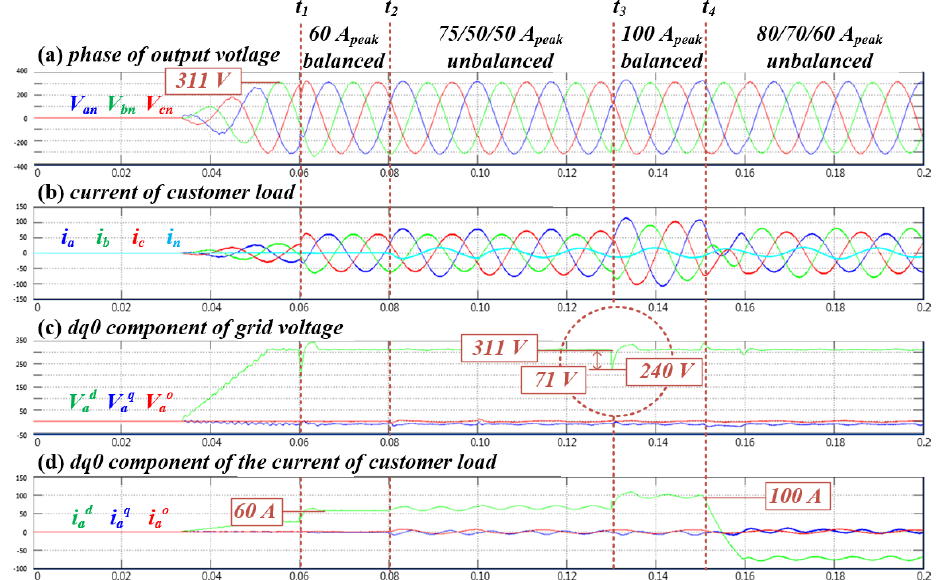
Figure 11. Performance of single-phase voltage control algorithm.